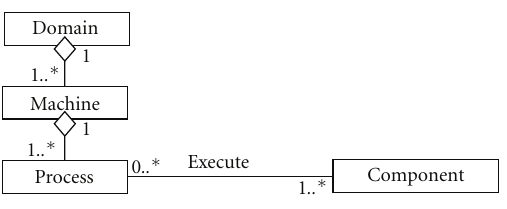
Figure 14: Modeling of domain